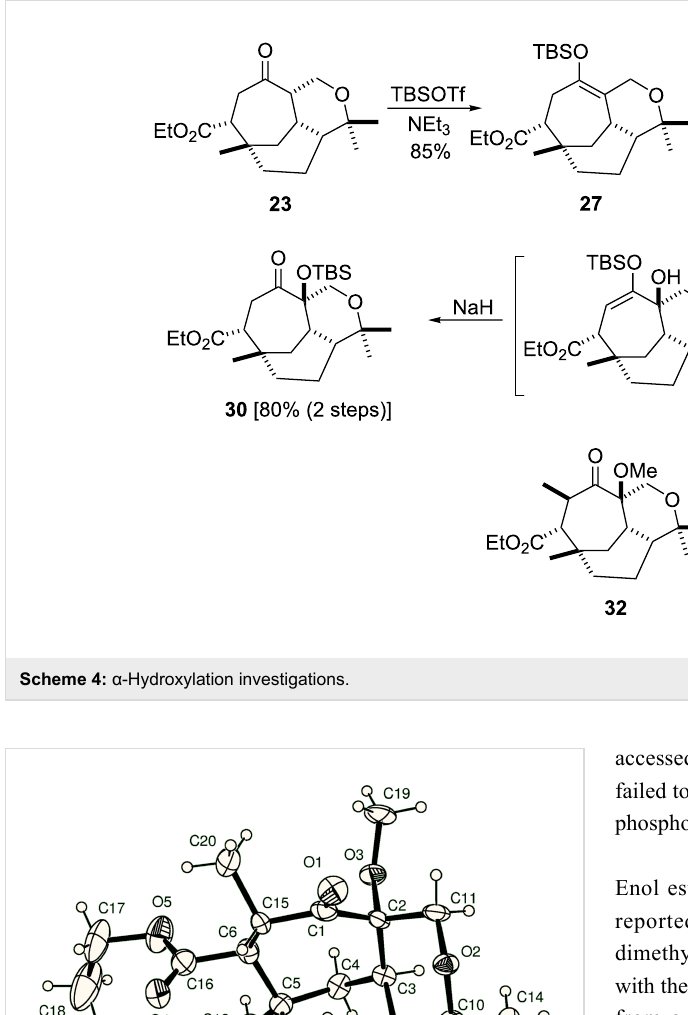
Nishizawa reported [22] the conversion of α-propargyl substi- tuted ketones directly into methylated furans using catalytic amounts of mercury triflate. Although verification of this substrate 39 failed to give the desired furan 42 (Scheme